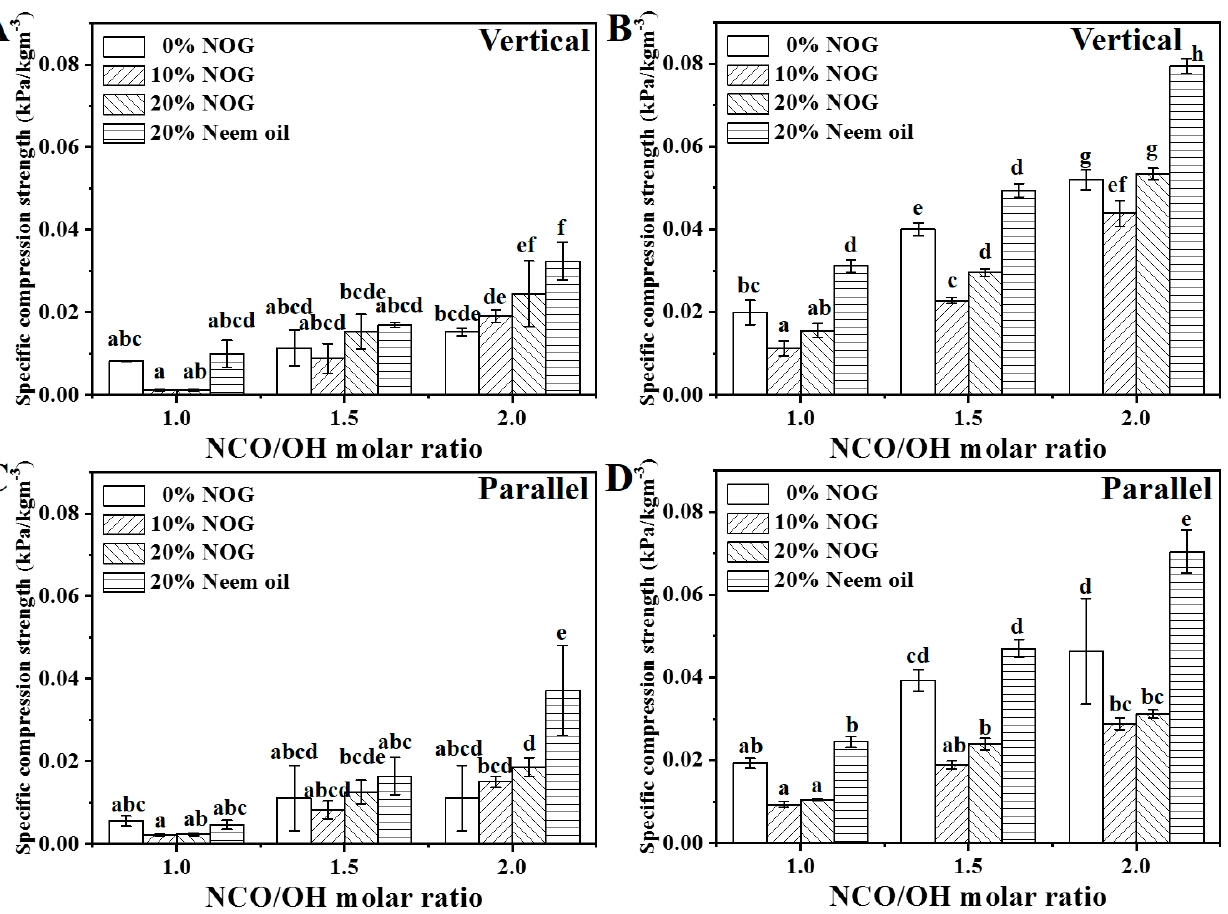
Figure 7. Specific compressive strength at 10% ( A , C ) and 25% ( B , D ) strain in the vertical and parallel directions. The NCO/OH molar ratios of O1-2, O2-2 and O3-2 set as 1.3, 1.9 and 2.5, respectively. The data analyzed using one-way ANOVA with Scheffe’s test, the different lowercase letters indicate statistical differences in the bar graph.